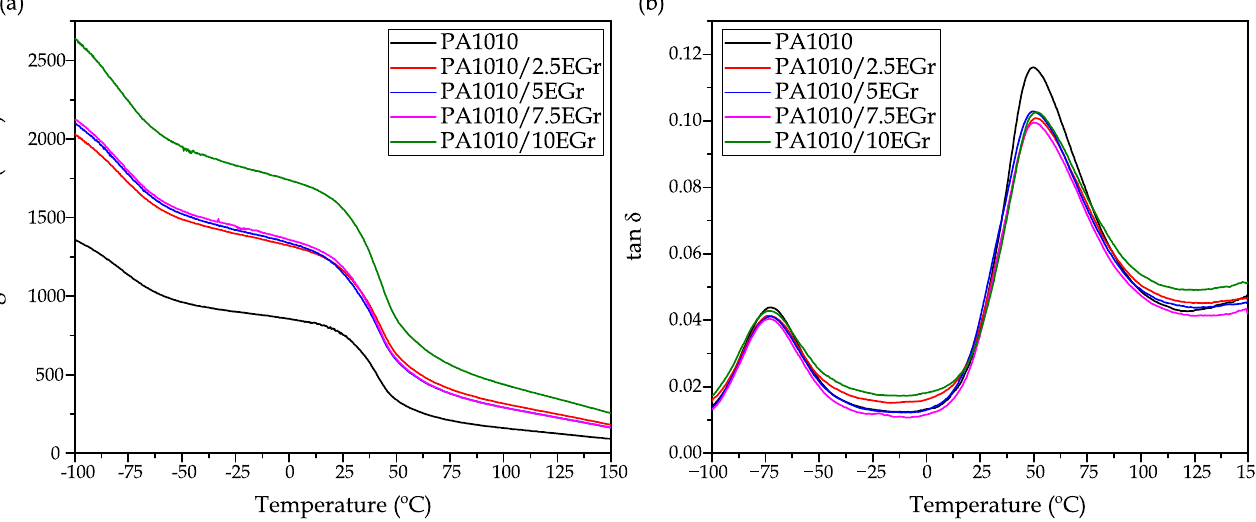
Figure 5. Thermomechanical properties of PA1010/EGr composites as a function of temperature, ( a ) storage modulus (E’) and ( b ) dynamic damping factor (tan δ ). Table 5. Thermomechanical properties of PA1010/EGr composites obtained via dynamic mechanical thermal analysis